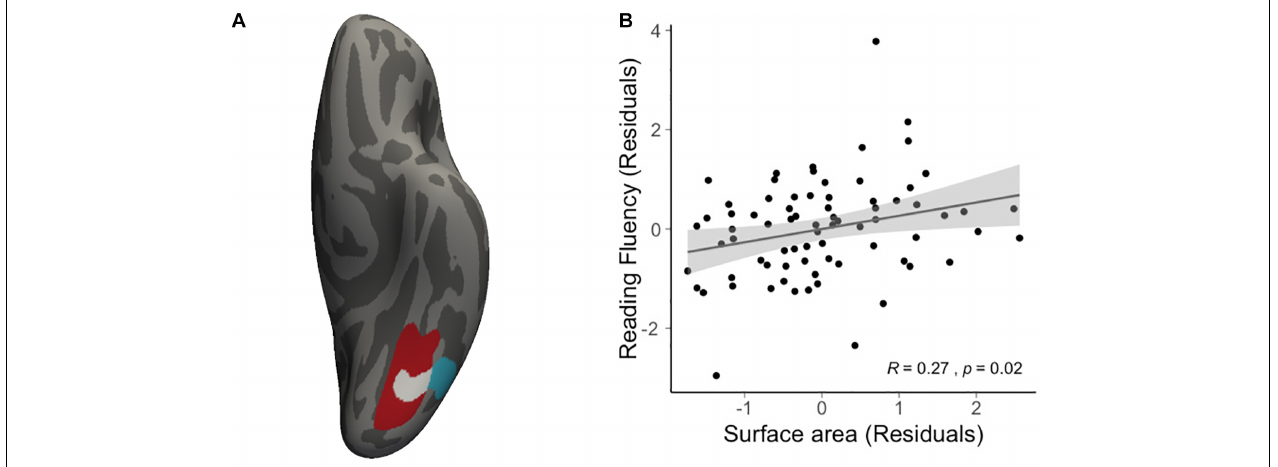
FIGURE 2 | Results of conjunction analysis. (A) The spatial overlap (white) of significant clusters obtained from whole brain analyses on the growth rate of VM (red) and character recognition at age 11 (cyan). (B) Scatter plot illustrates the positive correlation ( r = 0.27, t 73 = 2.37, p = 0.021) between average cortical surface area of the overlapping region and concurrent reading fluency at age 14, statistically controlling for age, sex and non-verbal